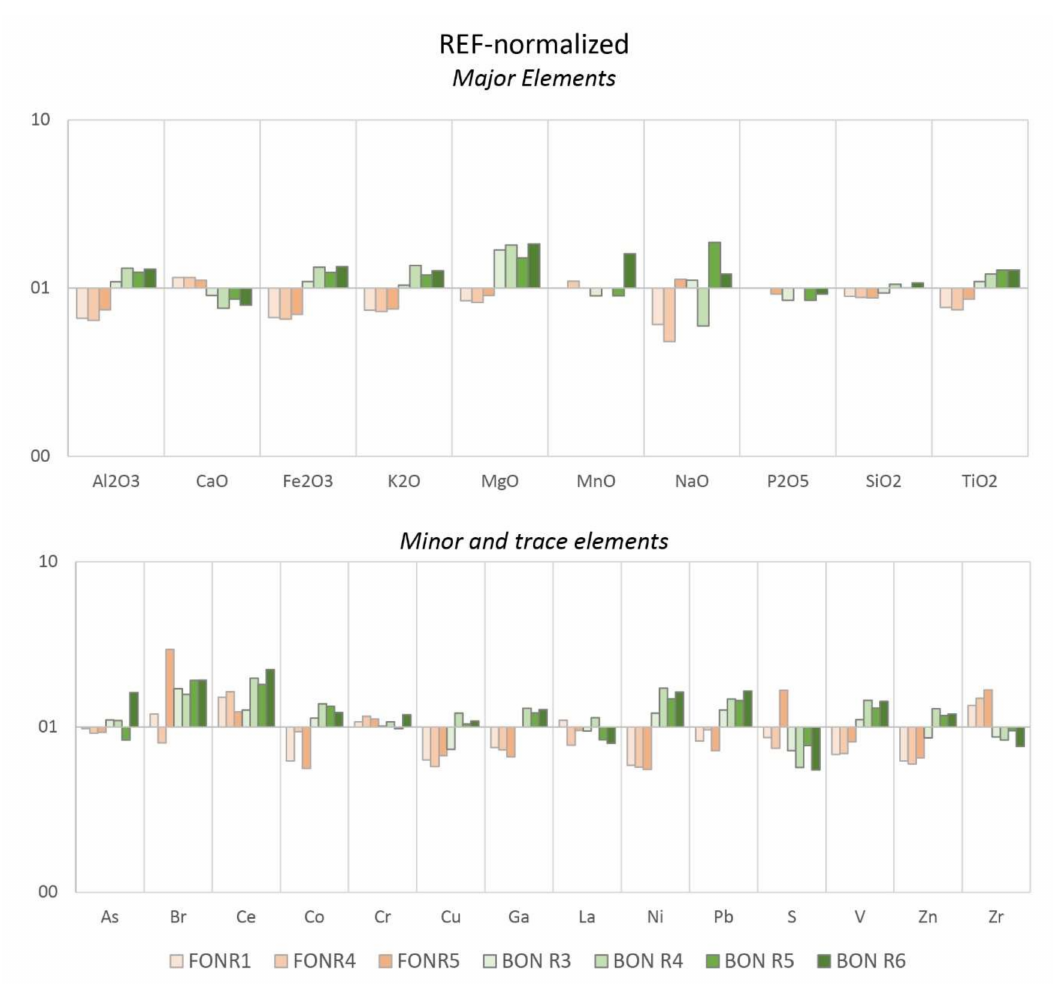
Figure 13. Enrichment factors of selected elements derived from the reference sample (REF) of this study. Orange and green histograms display the calculated ratios for Fontespina and Bonaccia sites,